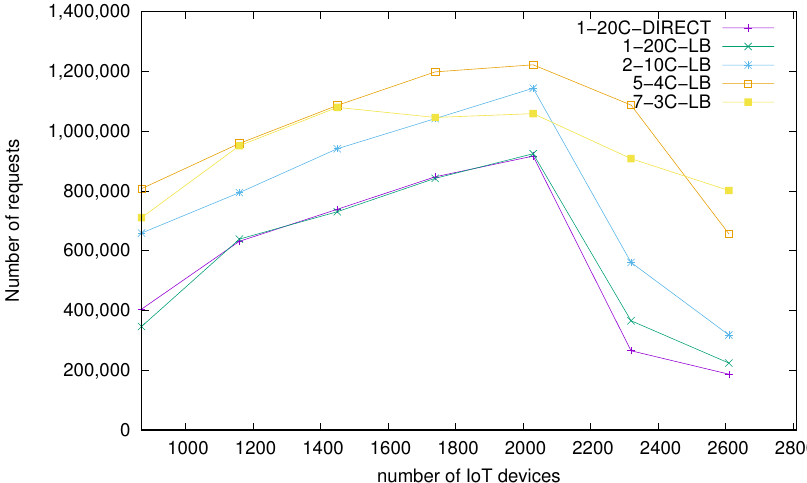
Figure 10. Number of successfully processed requests.